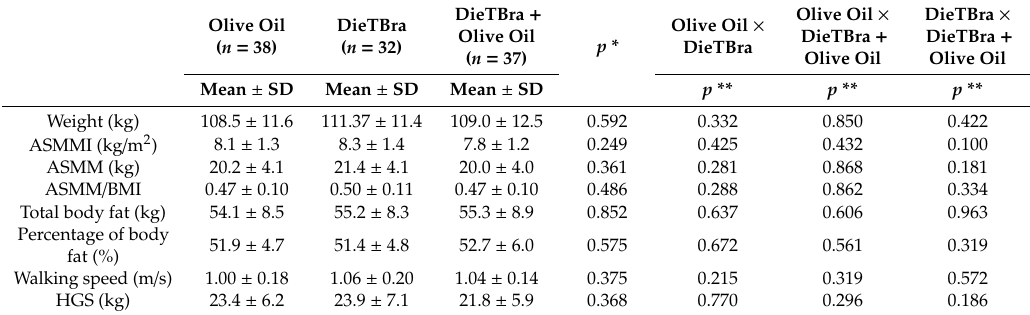
Table 3. Analysis of outcome variables in the final stage of follow-up according to intervention groups, and analysis comparing groups two to